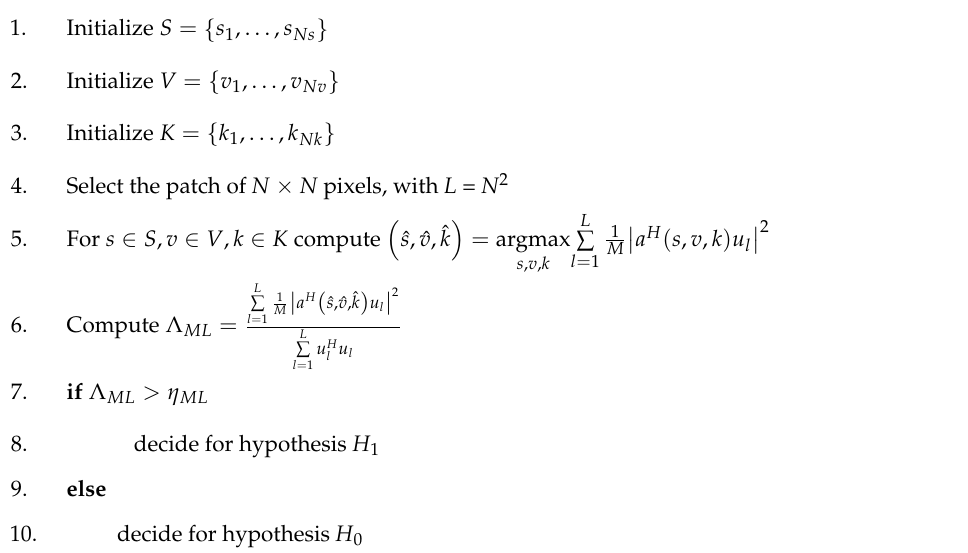
Table 1. Procedure for the detection of a single scatterer in a pixel of the SAR image.